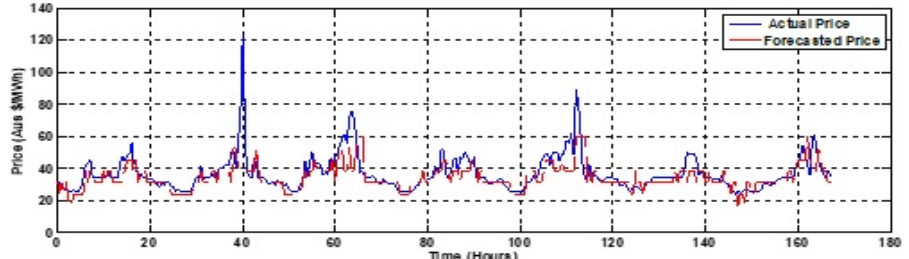
Figure 13. February 08–14, 2016 forecasting without feature selection in the summer season (MAPE = 12.81).